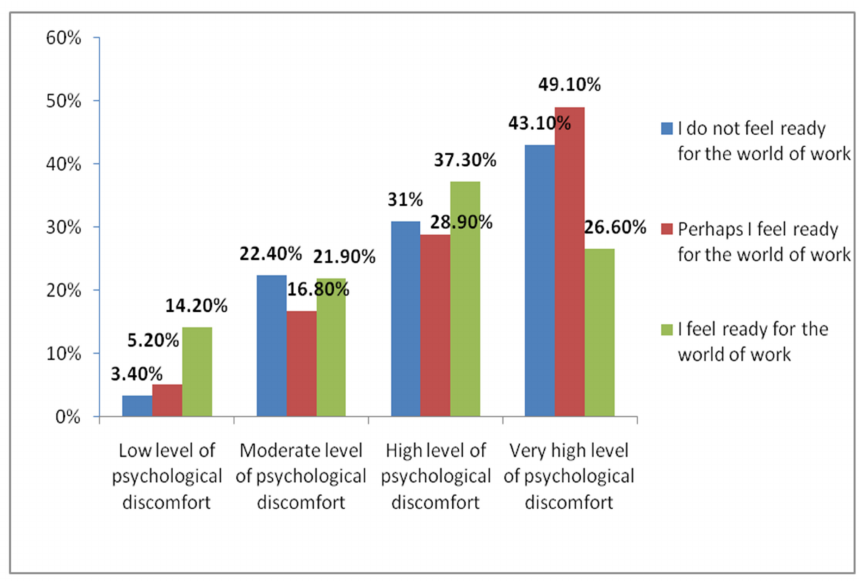
Figure 3. Correlation between psychological discomfort and feeling ready for the world of